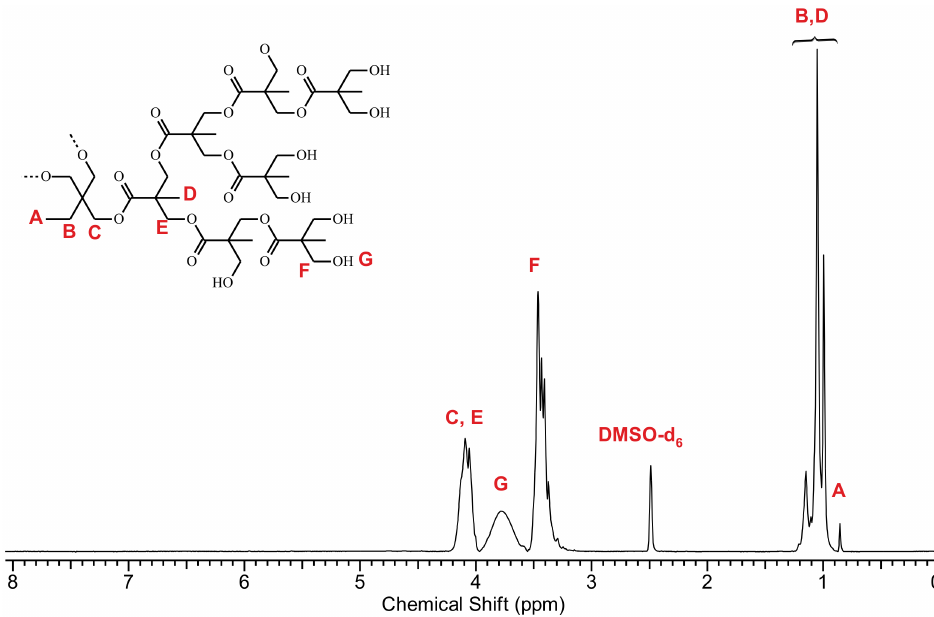
Figure 3. 1H-NMR spectrum and schematic architecture of Boltorn H40.